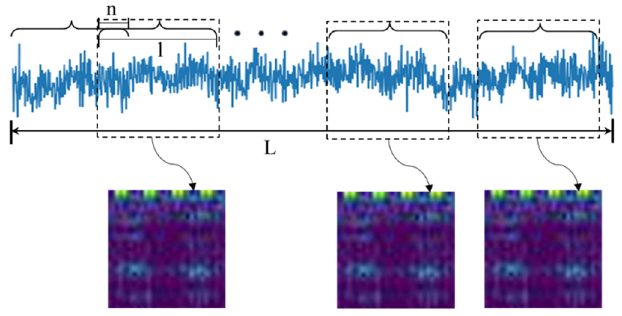
Figure 9. Data preprocessing process.